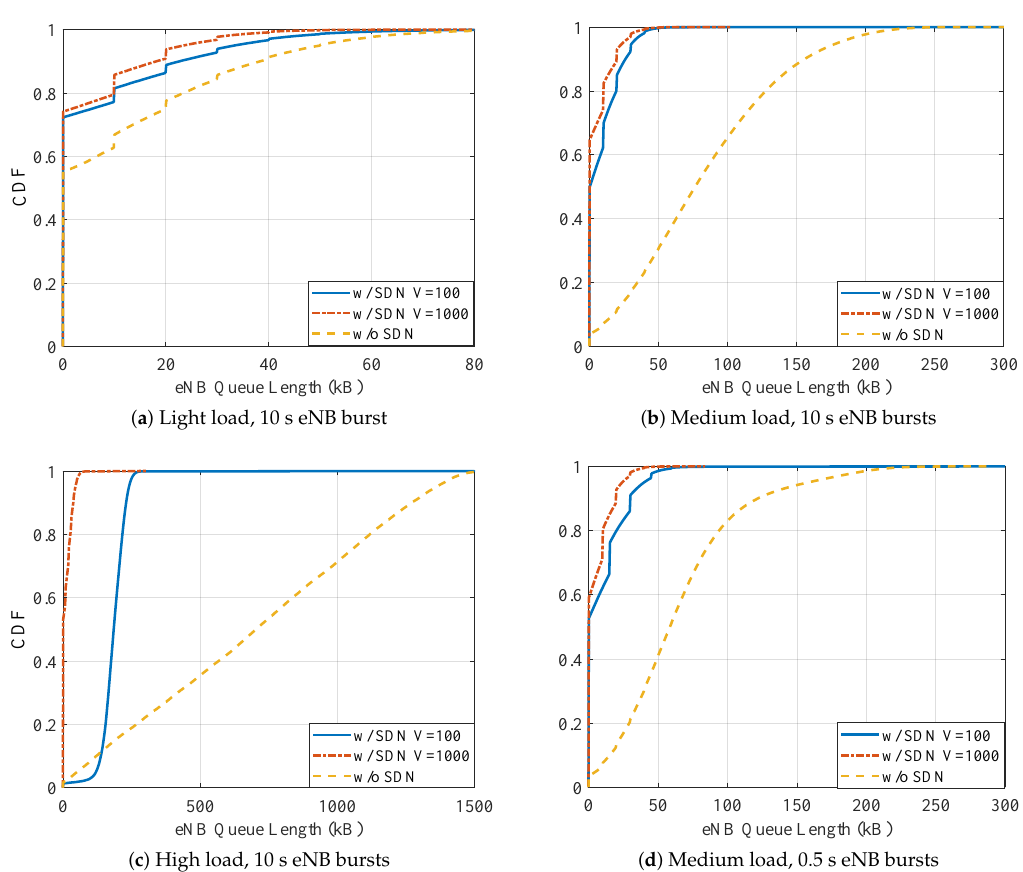
Figure 7. Cumulative distribution function (CDF) of eNB queue length for independent eNB traffic bursts with various load levels for long (10 s) bursts and medium load for short (0.5 s) bursts; fixed parameters: O = 20 operators, each with two gateways (each with five